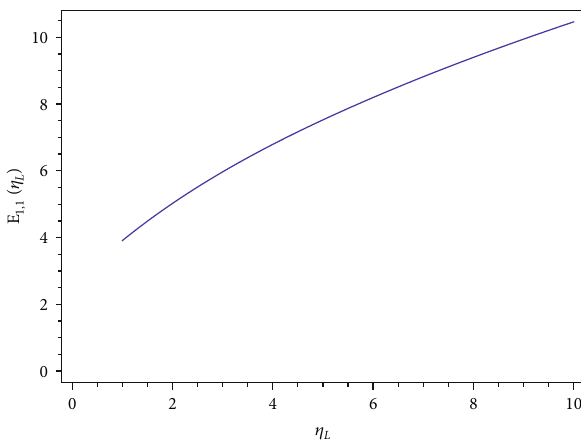
= 1 , α = 0 : 5 , ω = 0 : 5 c